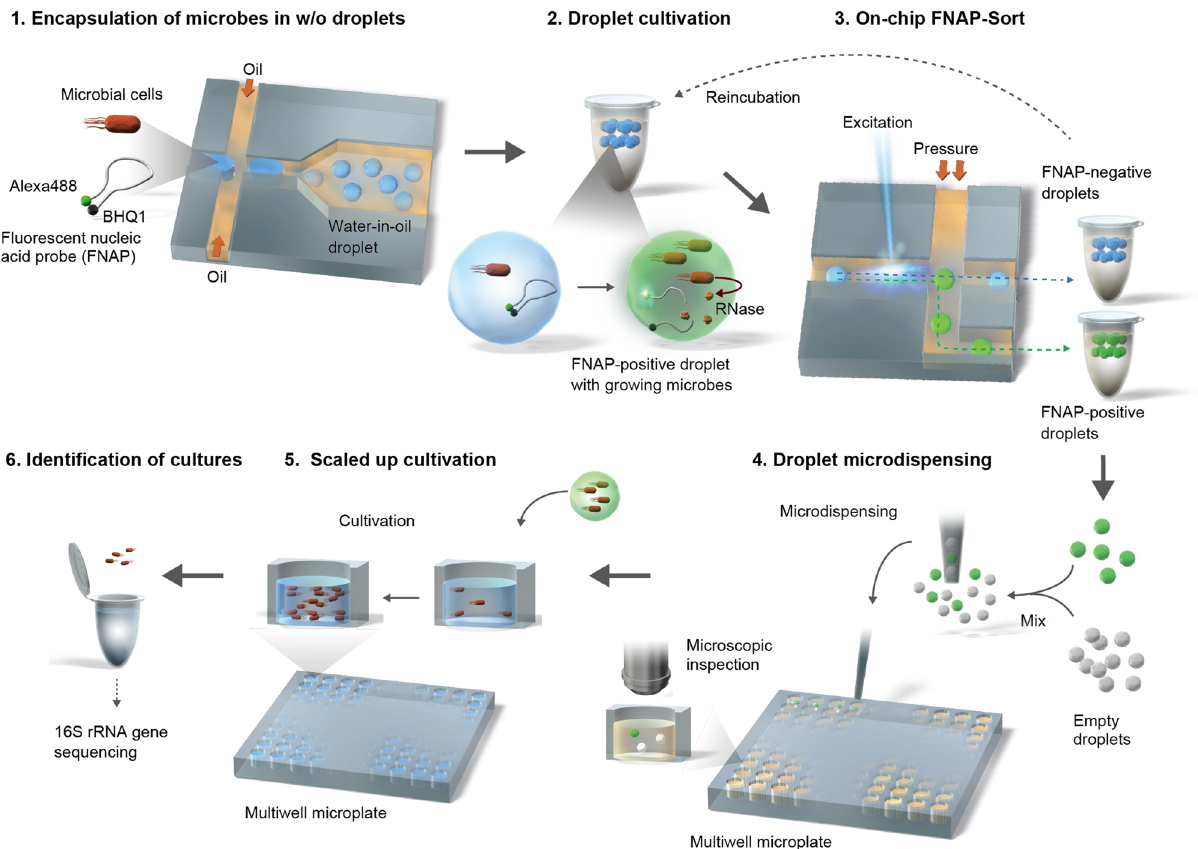
Figure 1. Schematic of the workflow for droplet-based cultivation and isolation of environmental microbes. Microbial cells and fluorescent nucleic acid probe (FNAP) are microfluidically encapsulated in w/o microdroplets (step 1). Following culturing under static conditions (step 2), droplets with strong FNAP-induced fluorescent signal are identified and recovered by on-chip FNAP-sort (step 3). Concurrently, droplets with weaker fluorescent signal (that is, FNAP-negative droplets) are retained and reincubated, as indicated by the dashed arrow, in order to recover slower-growing microbes. In step 4, FNAP-positive droplets are deposited in multiwell plates, following dilution with an appropriate volume of empty droplets (see text for details), by microdispensing, and optionally inspected by fluorescence microscopy. Cultures are finally scaled up (step 5) and identified by 16S rRNA gene amplicon sequencing (step